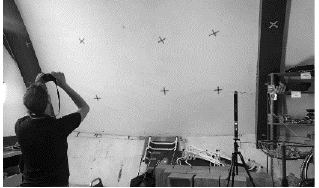
Figure 6. One of the Canadian students collecting interior photogrammetry data of the pavilion using a handheld DSLR camera.